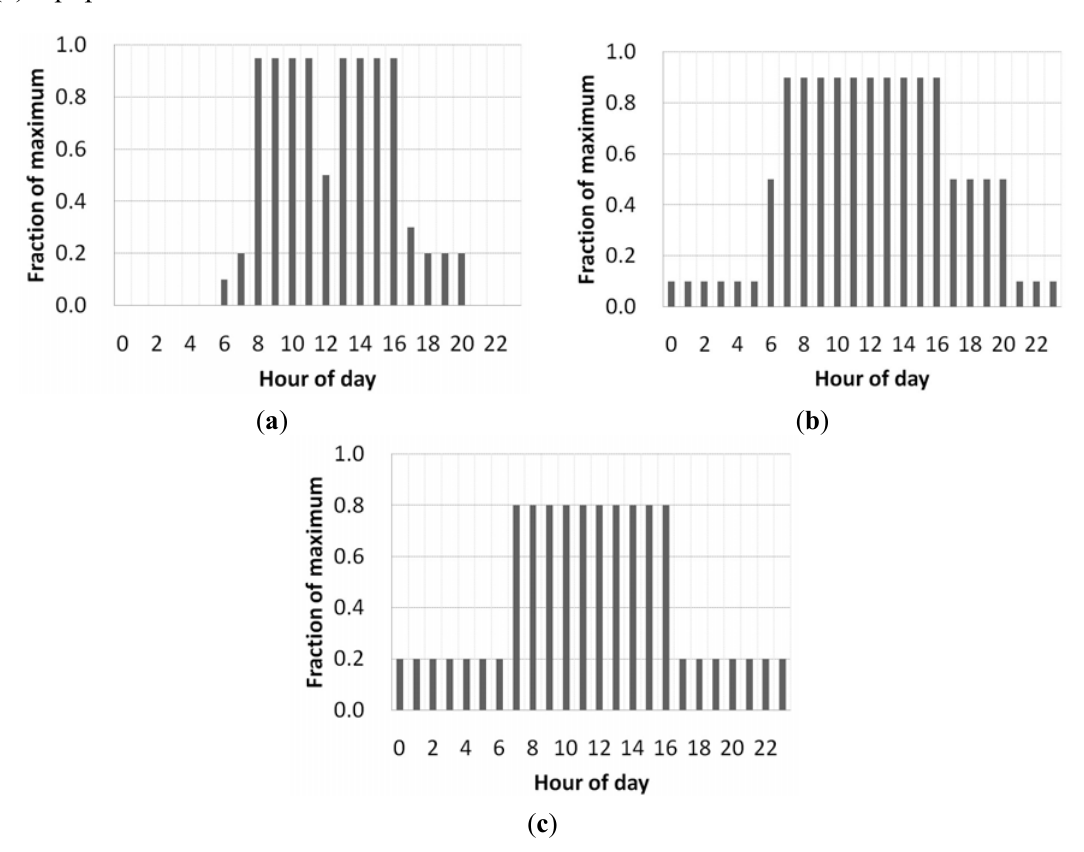
Figure 2. Occupancy, lighting and equipment schedules: ( a ) occupancy; ( b ) lighting; ( c )